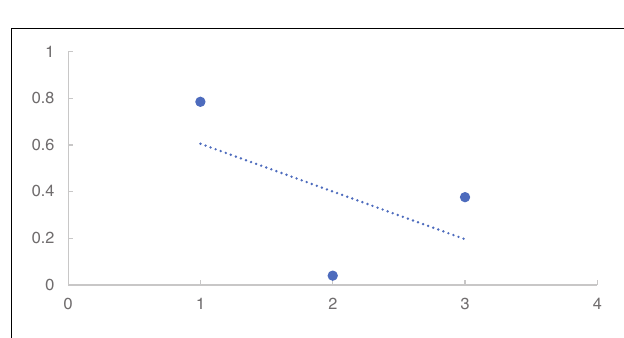
FIGURE 3 | The linear regression of correlation of three language style matching